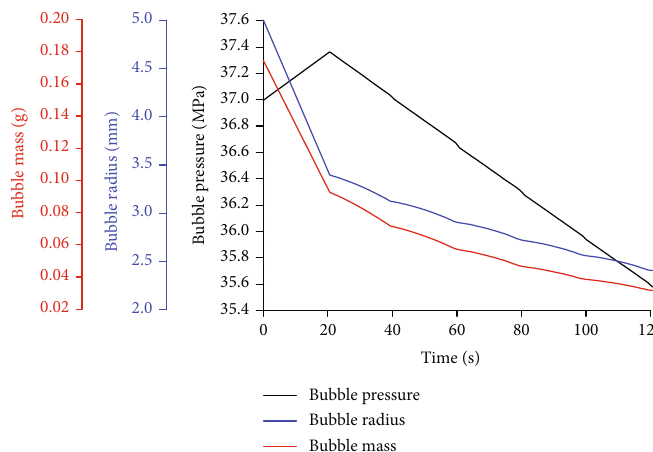
Figure 5: Variations of the pressure, radius, and mass of a gas bubble released at the initial time of gas kick (initial radius: 5 mm).